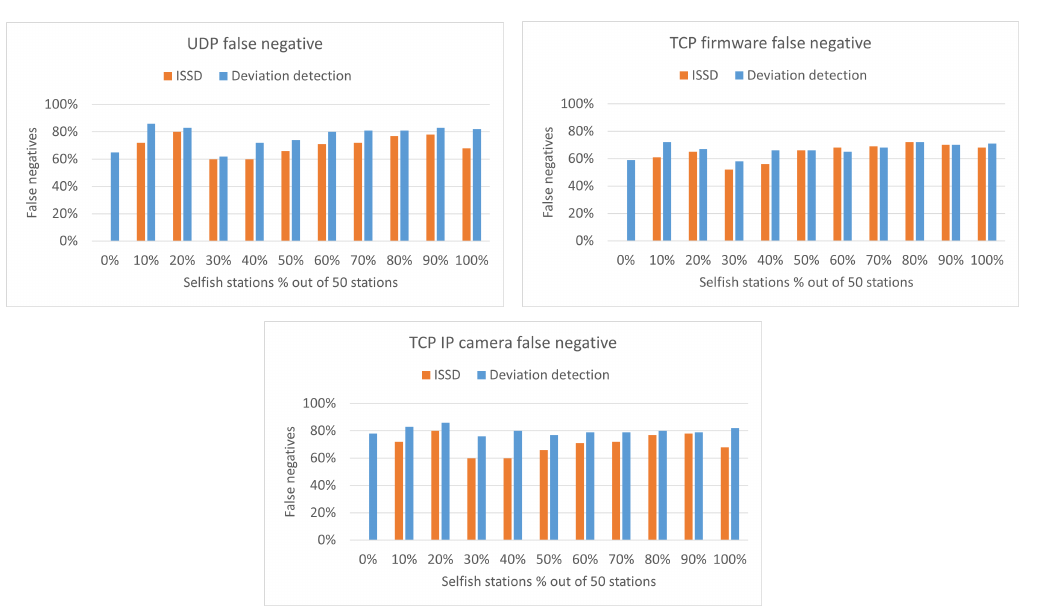
Figure 9. ( left ) True positive. ( right ) False positive—results of the detection algorithms for UDP, TCP firmware and TCP IP camera.